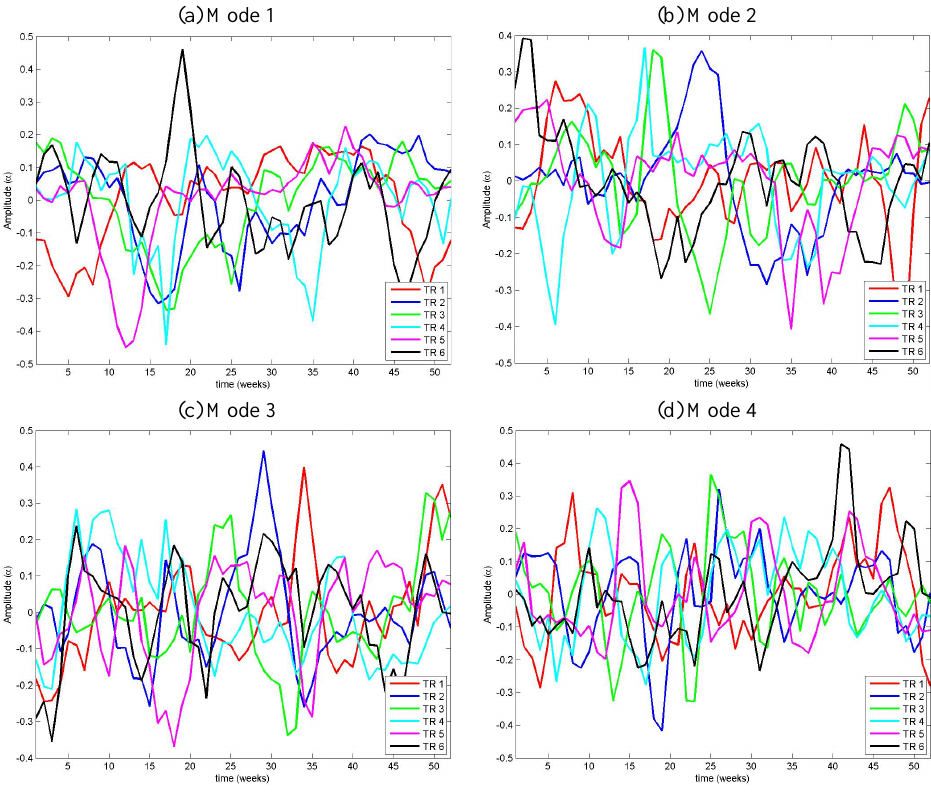
Fig. 14. The first four EOF modes of the thermal regions using s = 3, c = 3 and a moving window average threshold of 5